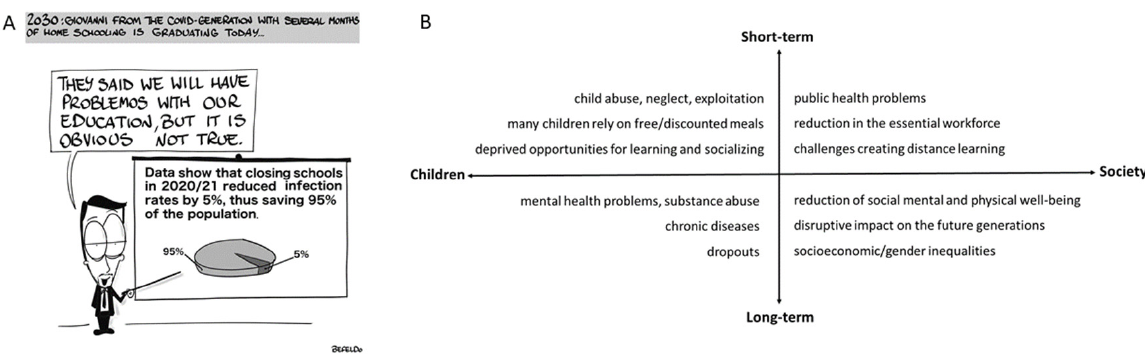
Figure 2. ( A ) School closure and the right to education. Deprived opportunities for learning are only one of the negative effects of school closure on children. ( B ) Side effects of school closure for children and society in the short- and long-term.